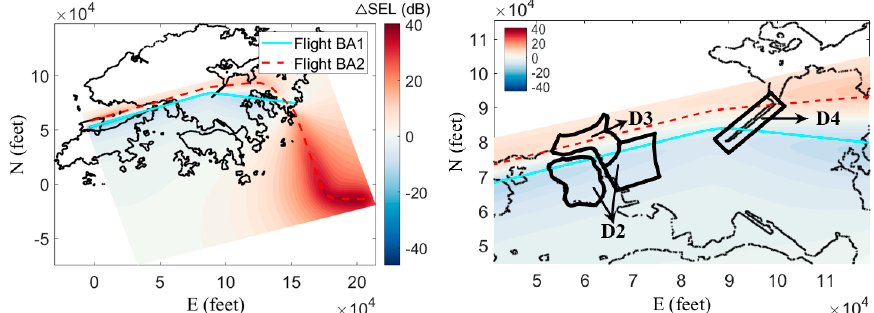
Figure 14. B777 aircraft approaching HKIA. Noise impact (SEL) generated by flight BA1 ( left ) and BA2 ( right ) over Hong Kong city.